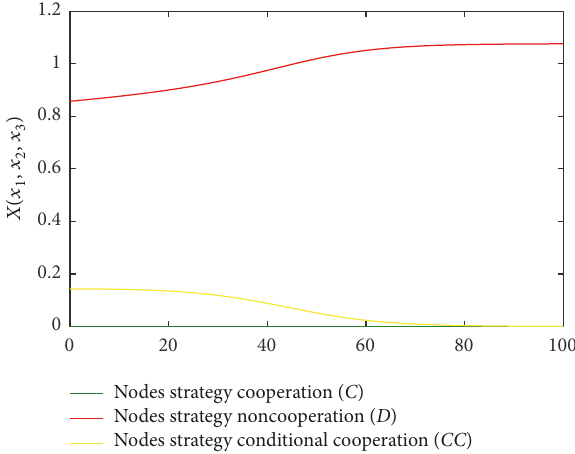
Figure 17: The state of population when 𝑥 = (0, 0.857, 0.142).